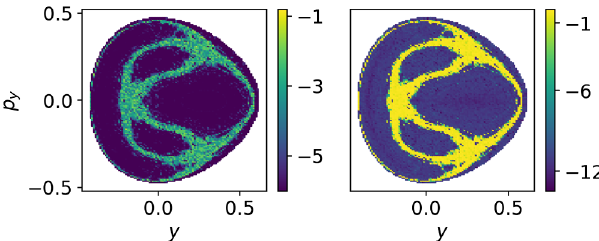
¼ 0 . 0 , y FIG. 5. Dynamic aperture of x ¼ 0 and E ¼ 1 = 12 surface projected on y − p plane. The color bar corresponds to the y measure of chaos Δ for the left and Δ for the FMA REM